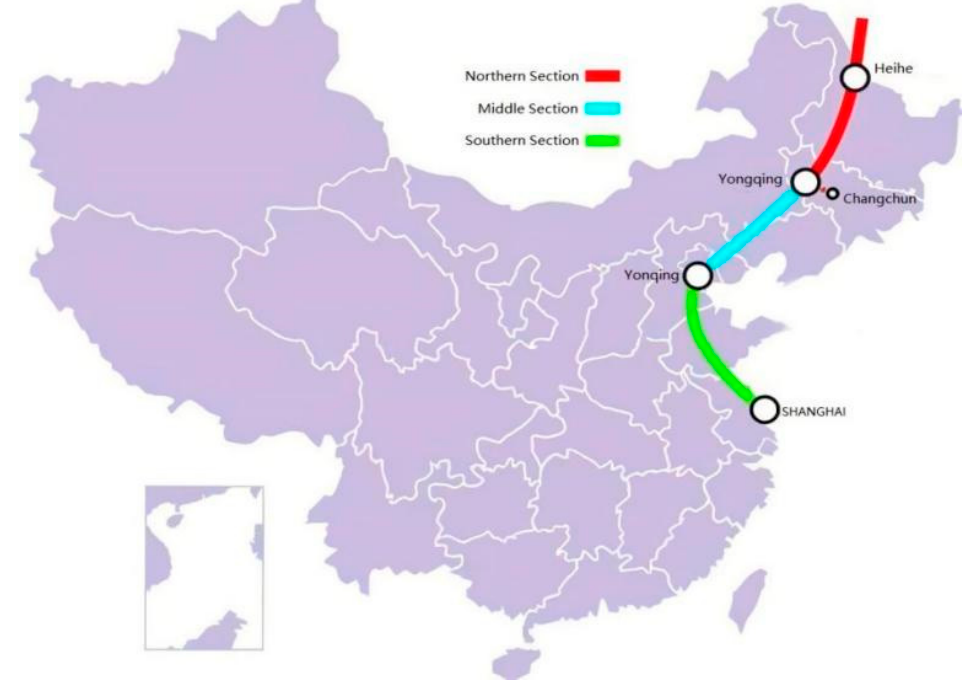
Figure 1. The route of the East China–Russia pipeline.